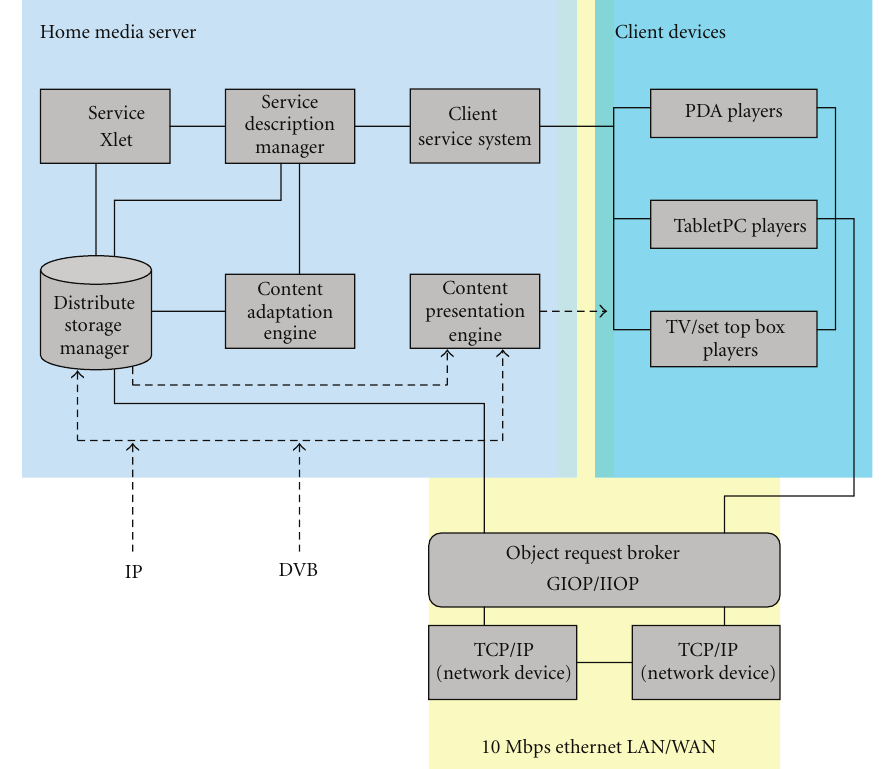
Figure 4: Structure of distributed platform for storage manager.